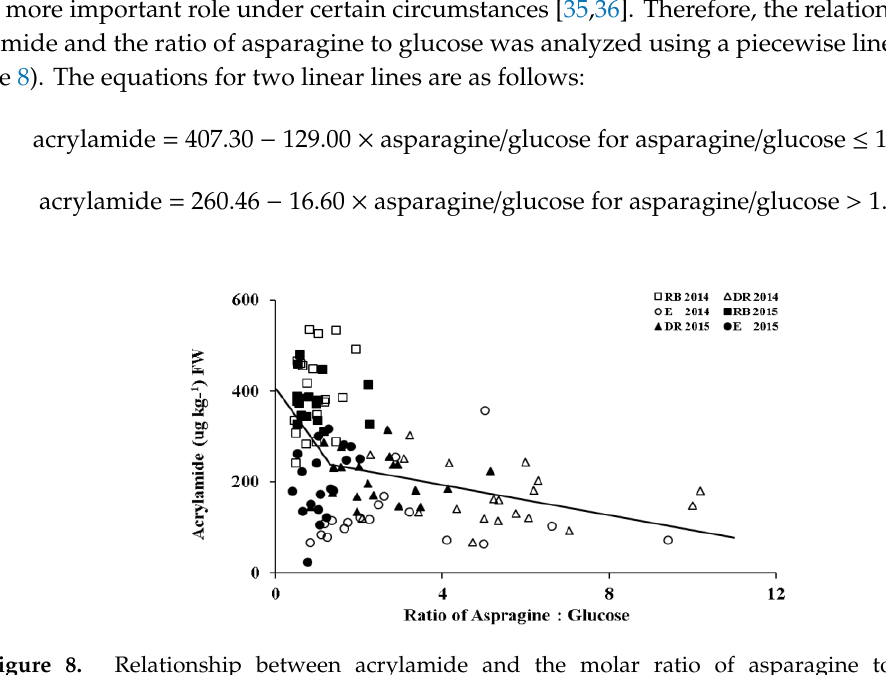
Figure 9. Relationships between acrylamide and asparagine ( a ) for Russet Burbank in two years and Easton in 2015, and ( b ) when asparagine/glucose ≤1.306. In Figure 9a, most values of asparagine/glucose for Russet Burbank in two years and Easton in 2015 fell into the range of less than 1.306 as shown in Figure 9b, demonstrating a strong correlation between acrylamide and asparagine ( r 2 = 0.41). The ratio of asparagine/glucose was greater than 1.306 for Dakota Russet in both years and for Easton in 2014 (data not shown). No effects of N rate on asparagine/glucose ratio were observed at 16 weeks of storage. This result suggests that cultivar and environmental conditions during the growing season were more important than N rate in affecting the relative concentrations of reducing sugars and asparagine, and consequently their relationships with acrylamide. 3.4. Relationships between Fry Color, Glucose, and Acrylamide at 16 Weeks of Storage